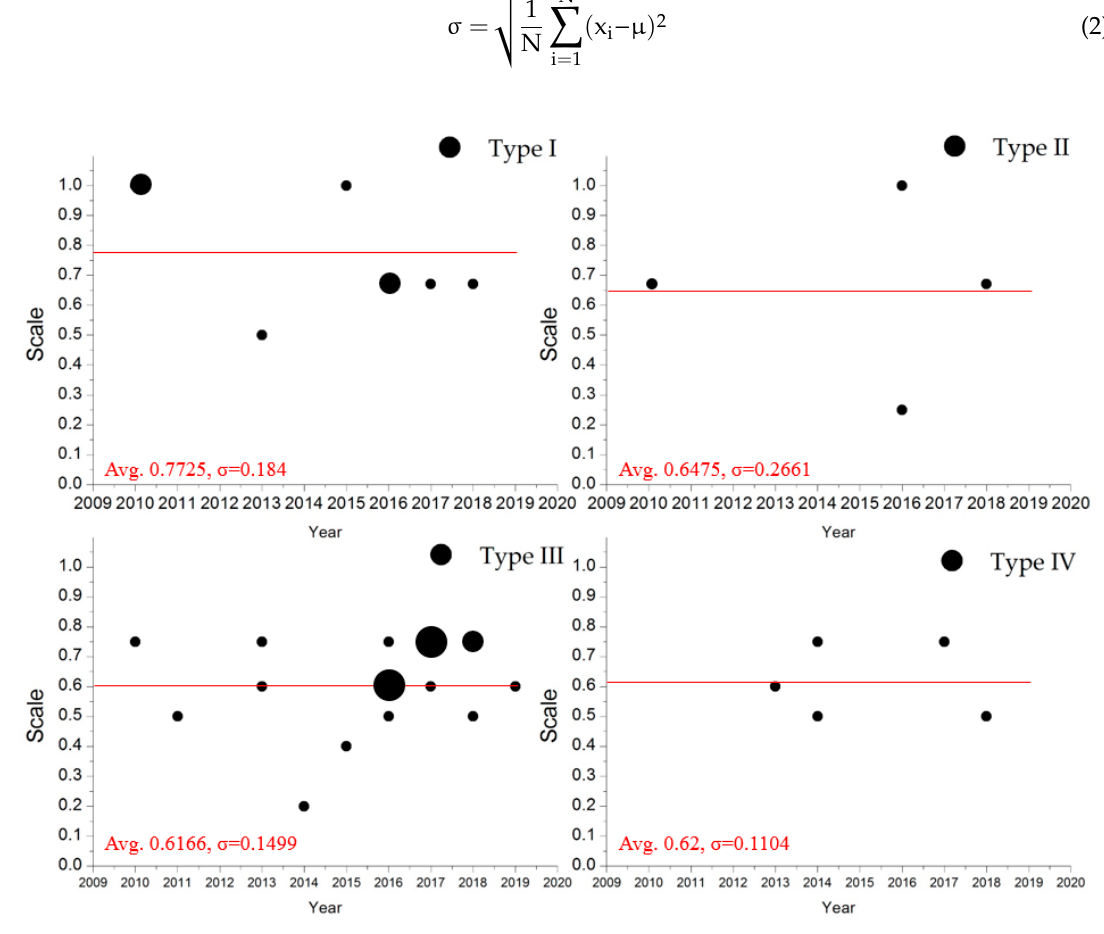
Figure 5. Daylight performance/cost distribution of the four types system.